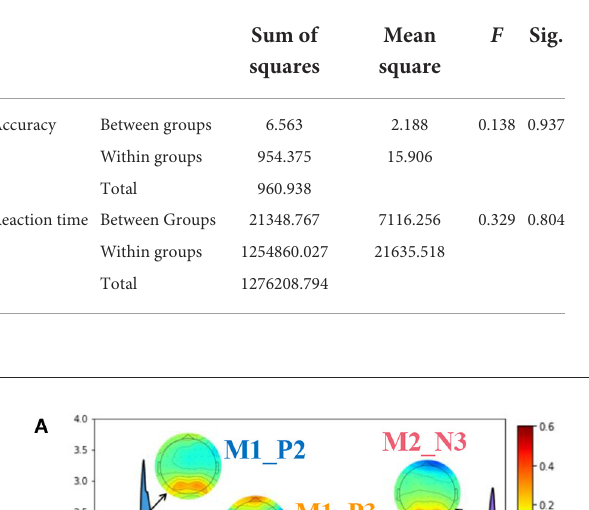
TABLE 1 ANOVA results for behavioral data (decision accuracy and reaction time).